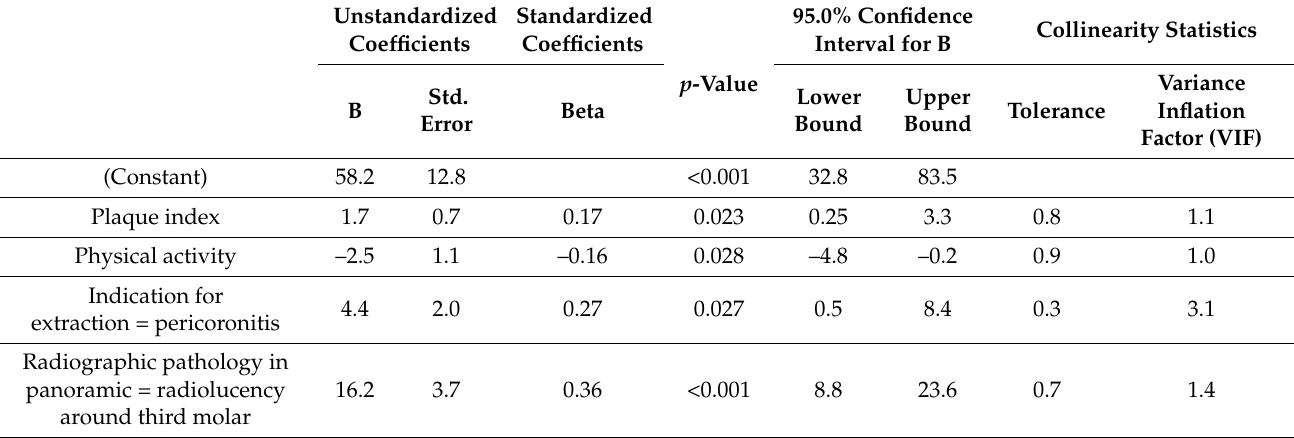
Table 5. Multivariate linear regression analysis of OHIP-14 global score as a dependent variable.